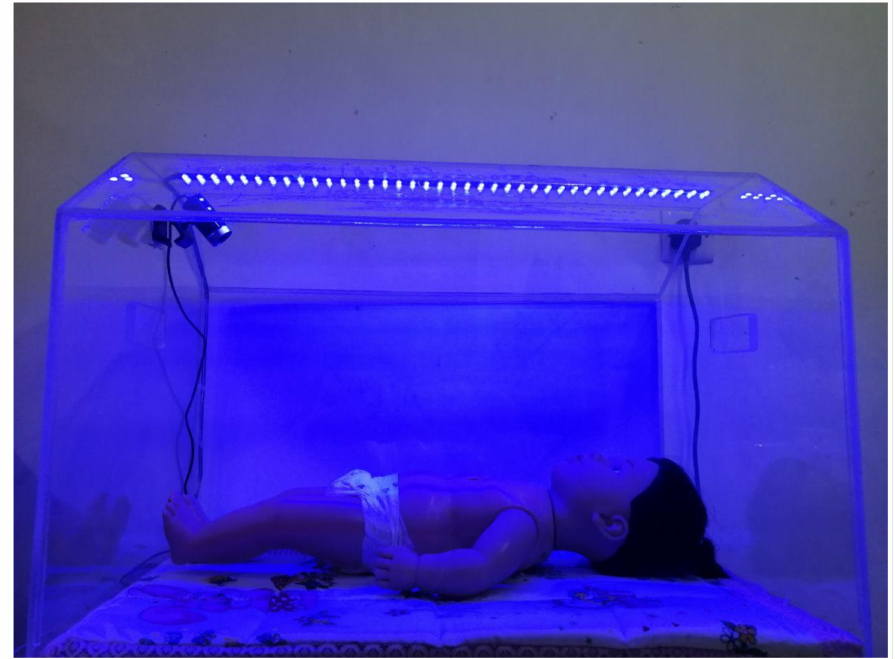
Figure 2. The system’s camera and blue LED when using manikin that has a yellowish light